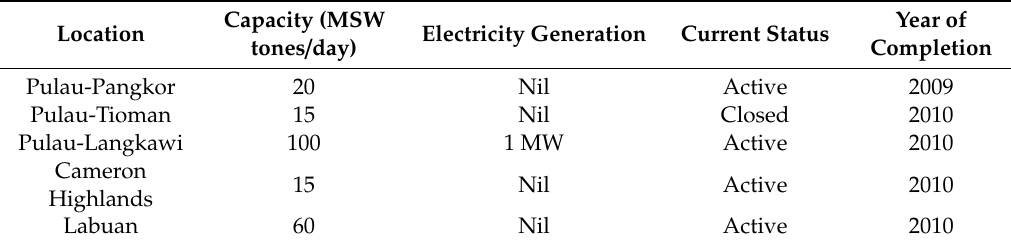
Table 3. The summary of the five incineration plants which are funded by the Ministry of Local Government and Housing (MHLG) in Malaysia